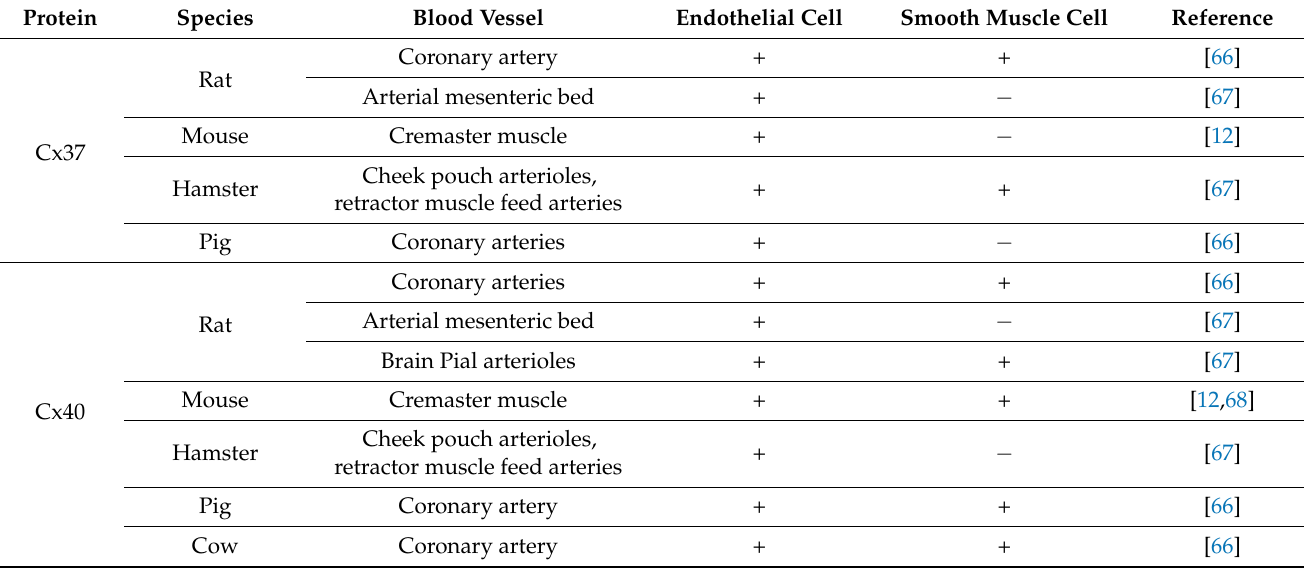
Table 1. Connexin and Pannexin protein distribution in arterioles (+ expression/ − no expression).